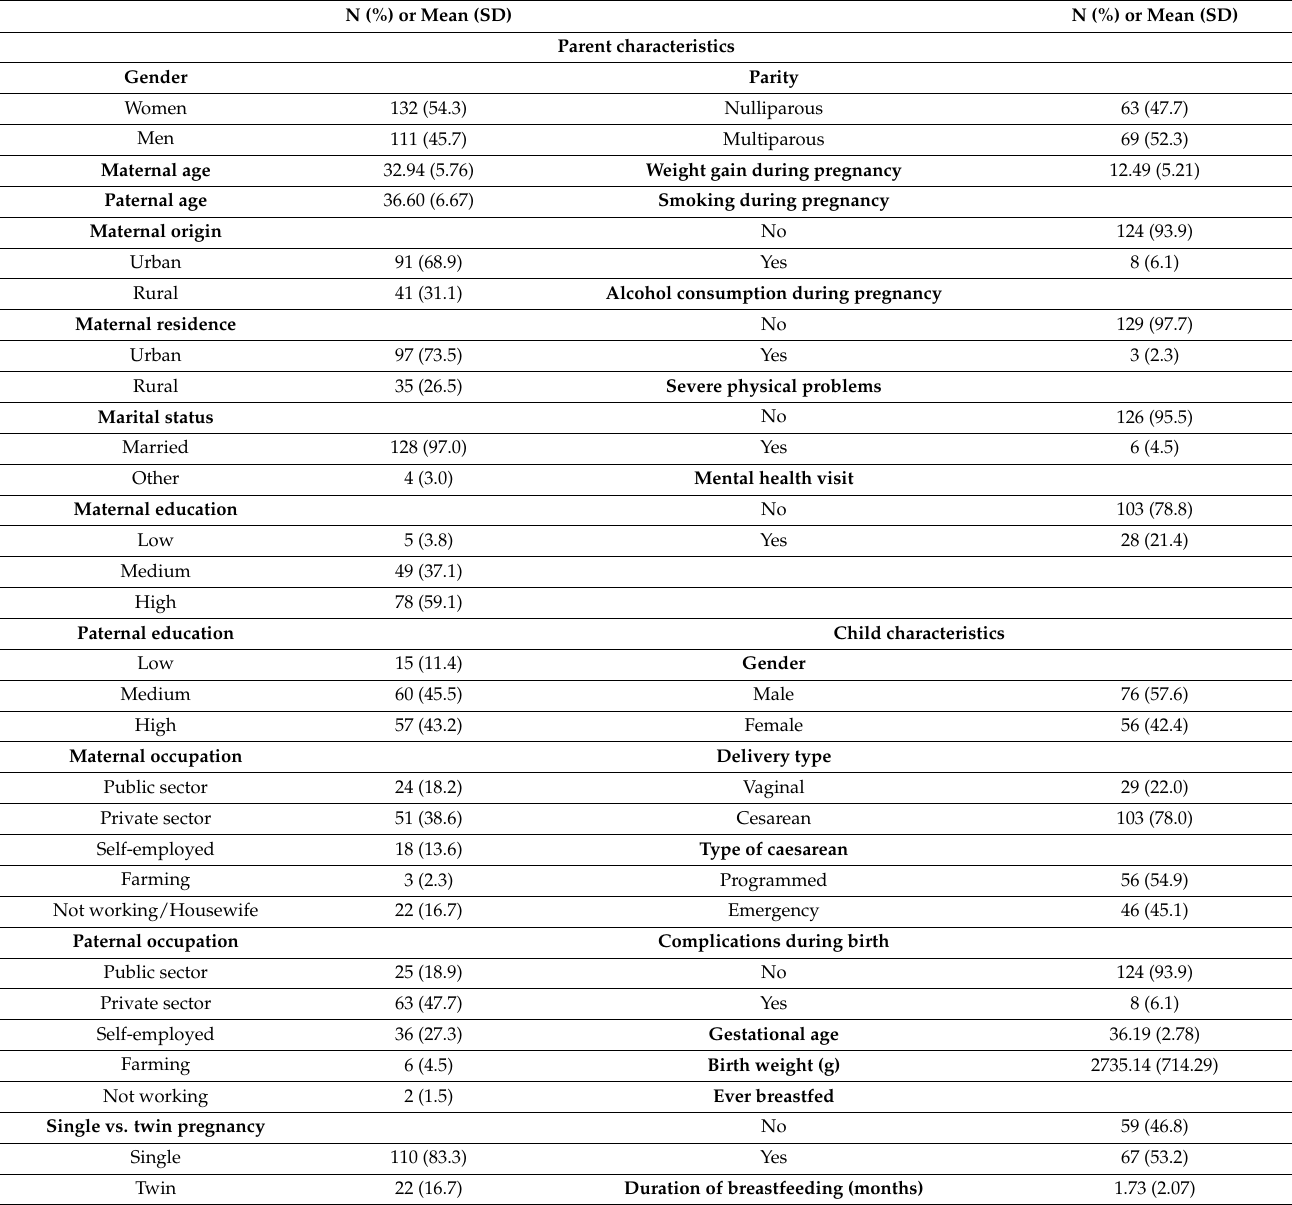
Table 1. Descriptive characteristics of the study